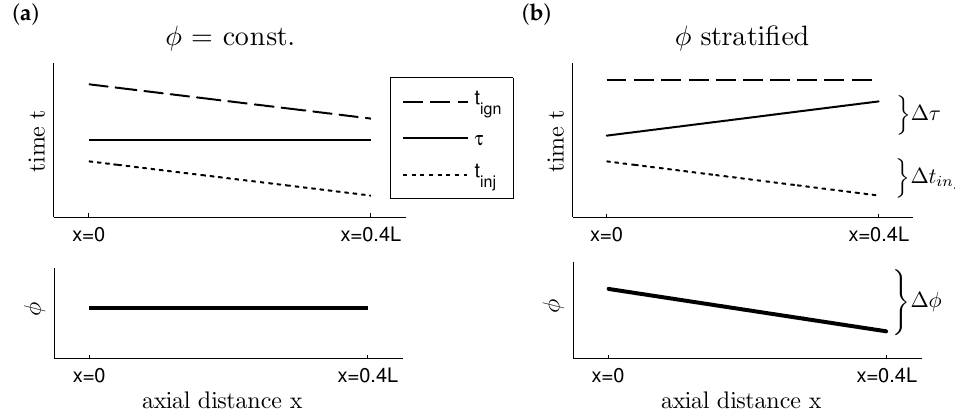
Figure 1. Sketch of the effect of equivalence ratio stratification on ignition delay time distribution (for details see text). ( a ) constant fuel profile ( b ) stratified fuel